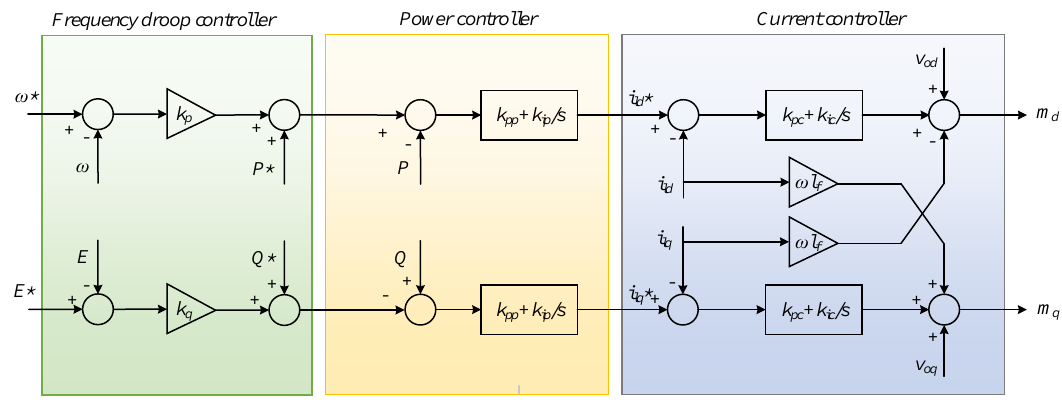
Figure 5. Control scheme of grid-feeding converter.